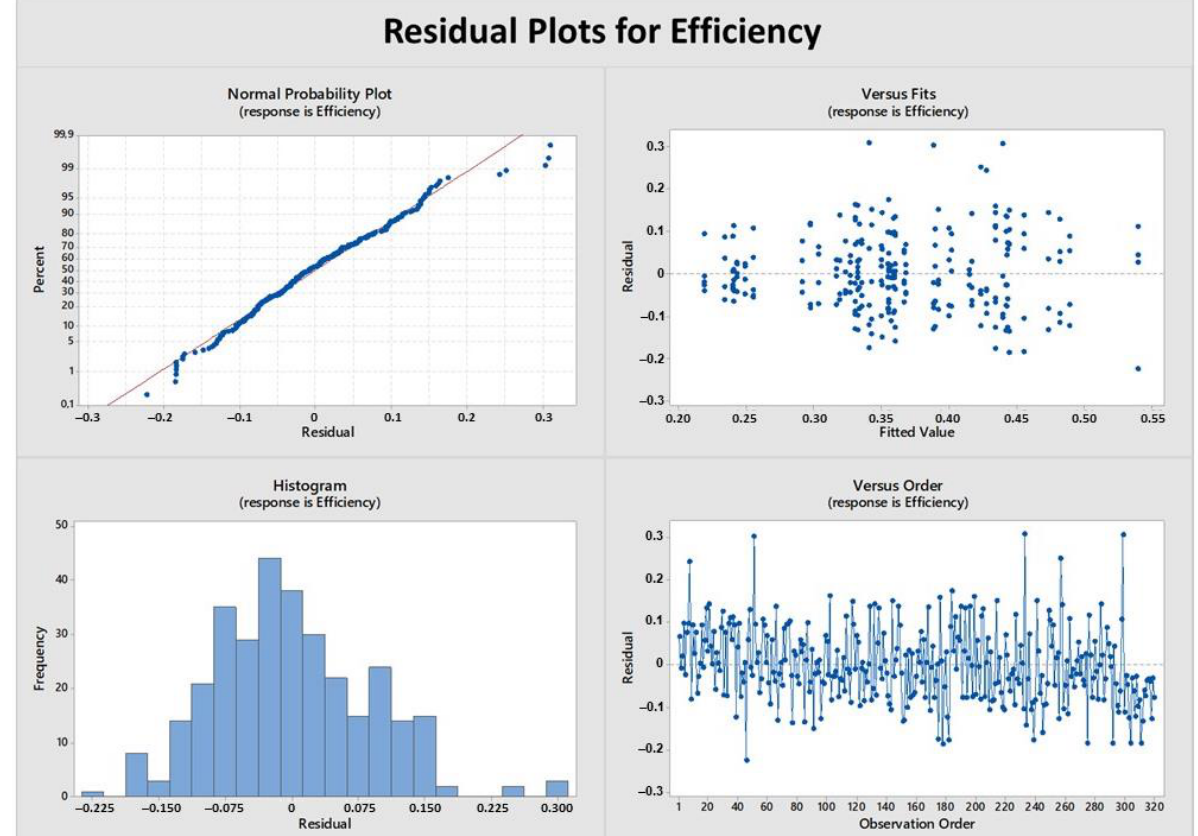
Figure 10. Residual plots for order-picking efficiency.